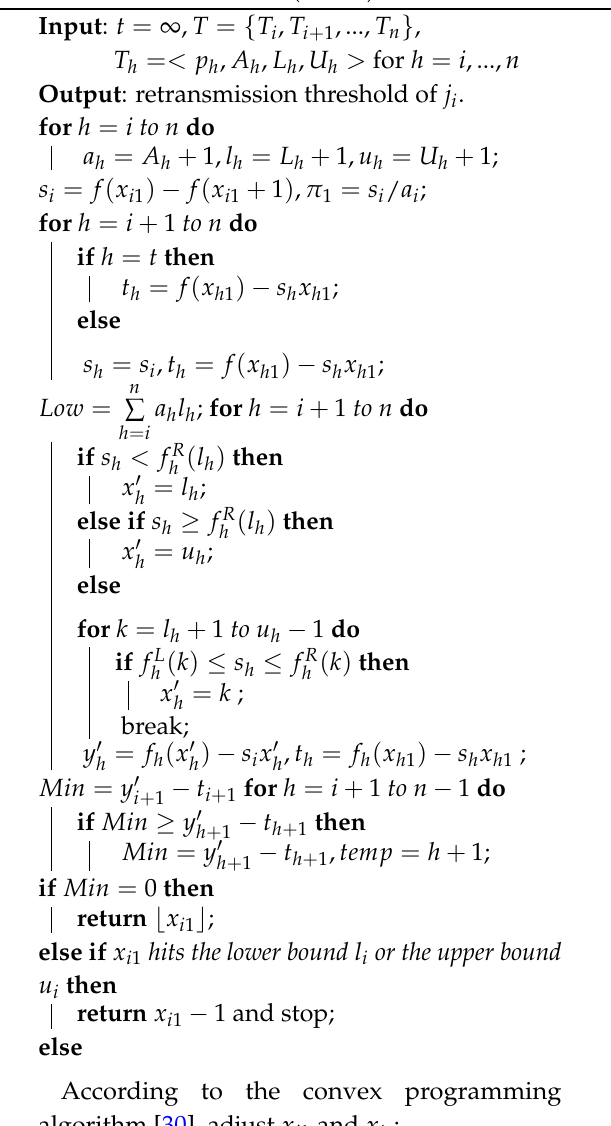
Algorithm 2: Linear Programming-Based distributed Approximation Algorithm for the retransmission threshold